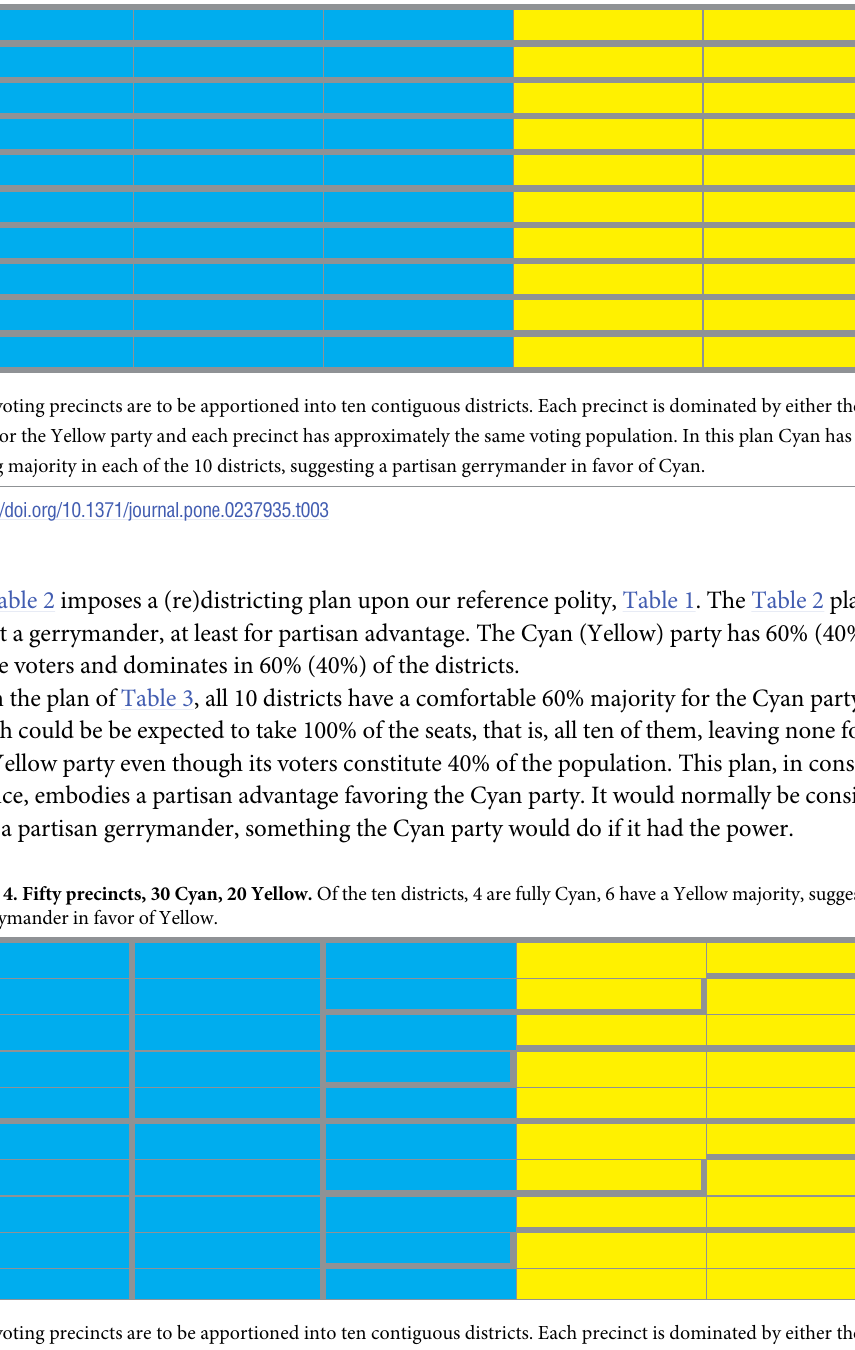
Table 3. Fifty precincts, 30 Cyan, 20 Yellow. The ten districts all favor of Cyan, which has 60% of the vote in each district.